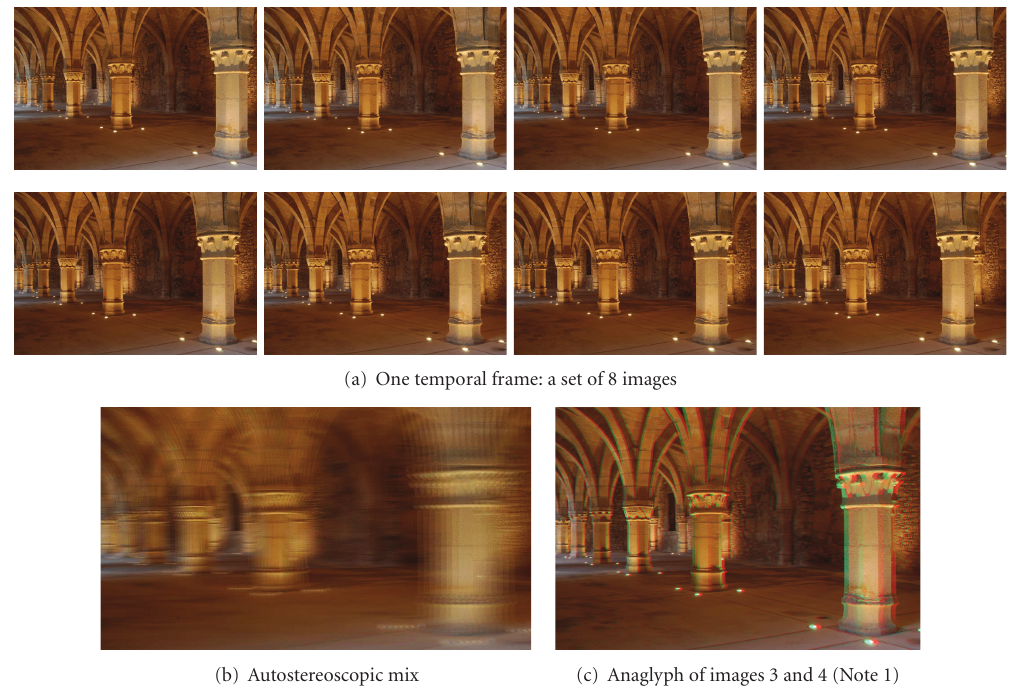
Figure 7: “Palais du Tau” result of Photo Rail with courtesy of Monum.